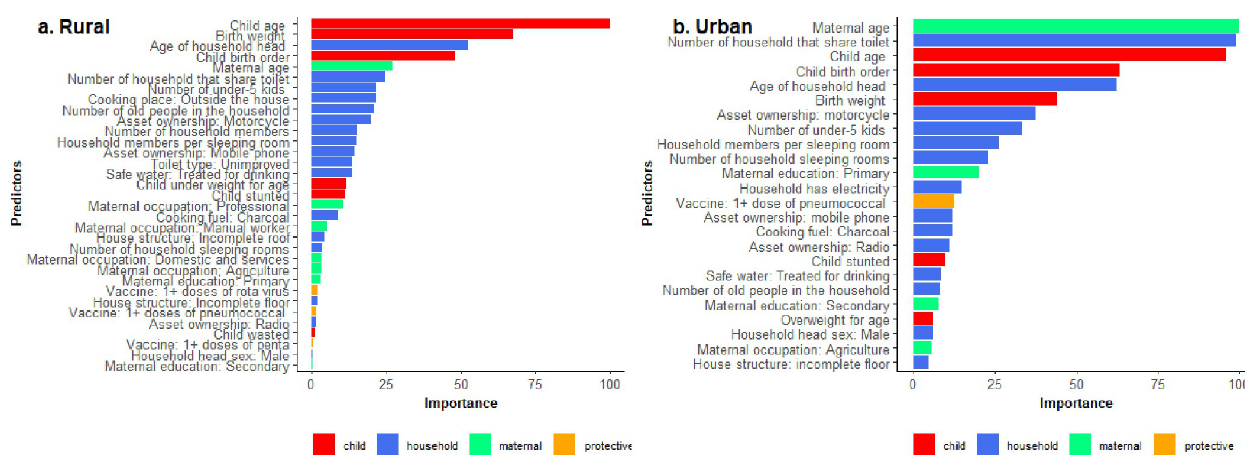
Fig 2. Key household and individual predictors of suspected diarrhoea in rural and urban areas identified through the analysis of 2006–2016 Uganda demographic health surveys data. The identification of variables is based on the best performing ML model, the GBM.